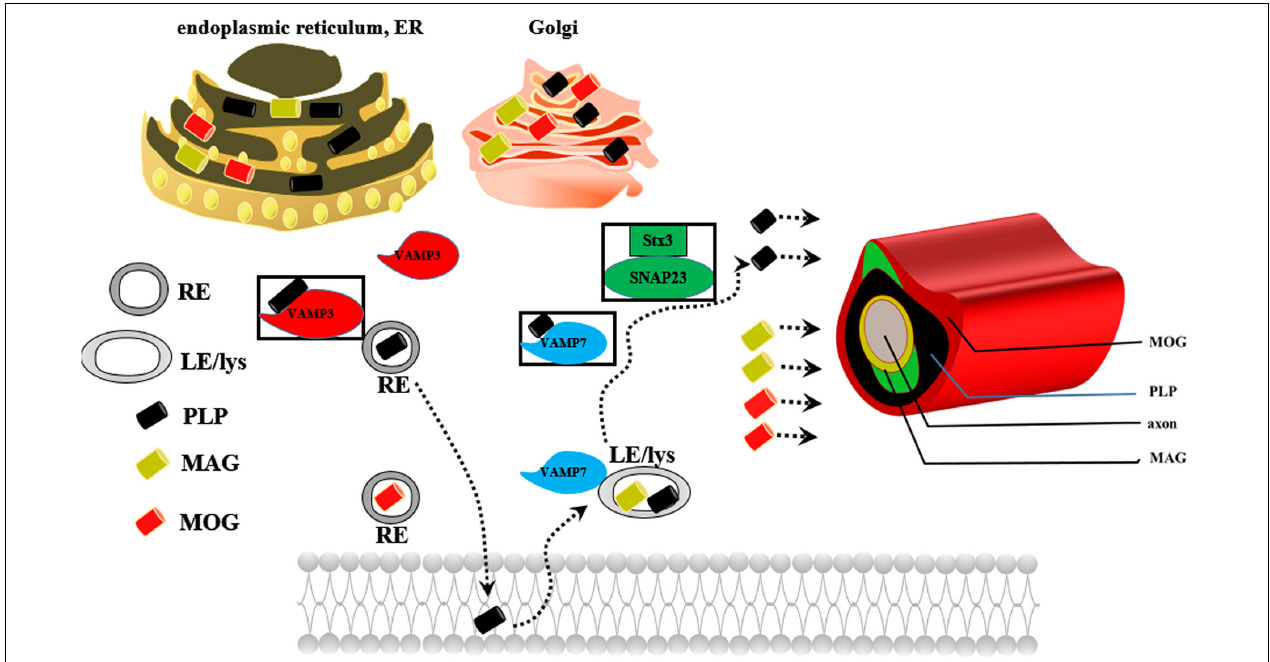
FIGURE 4 | The possible mechanism underlying the role of PLP in myelin biogenesis. REs, recycling endosomes; LEs/Lys, late